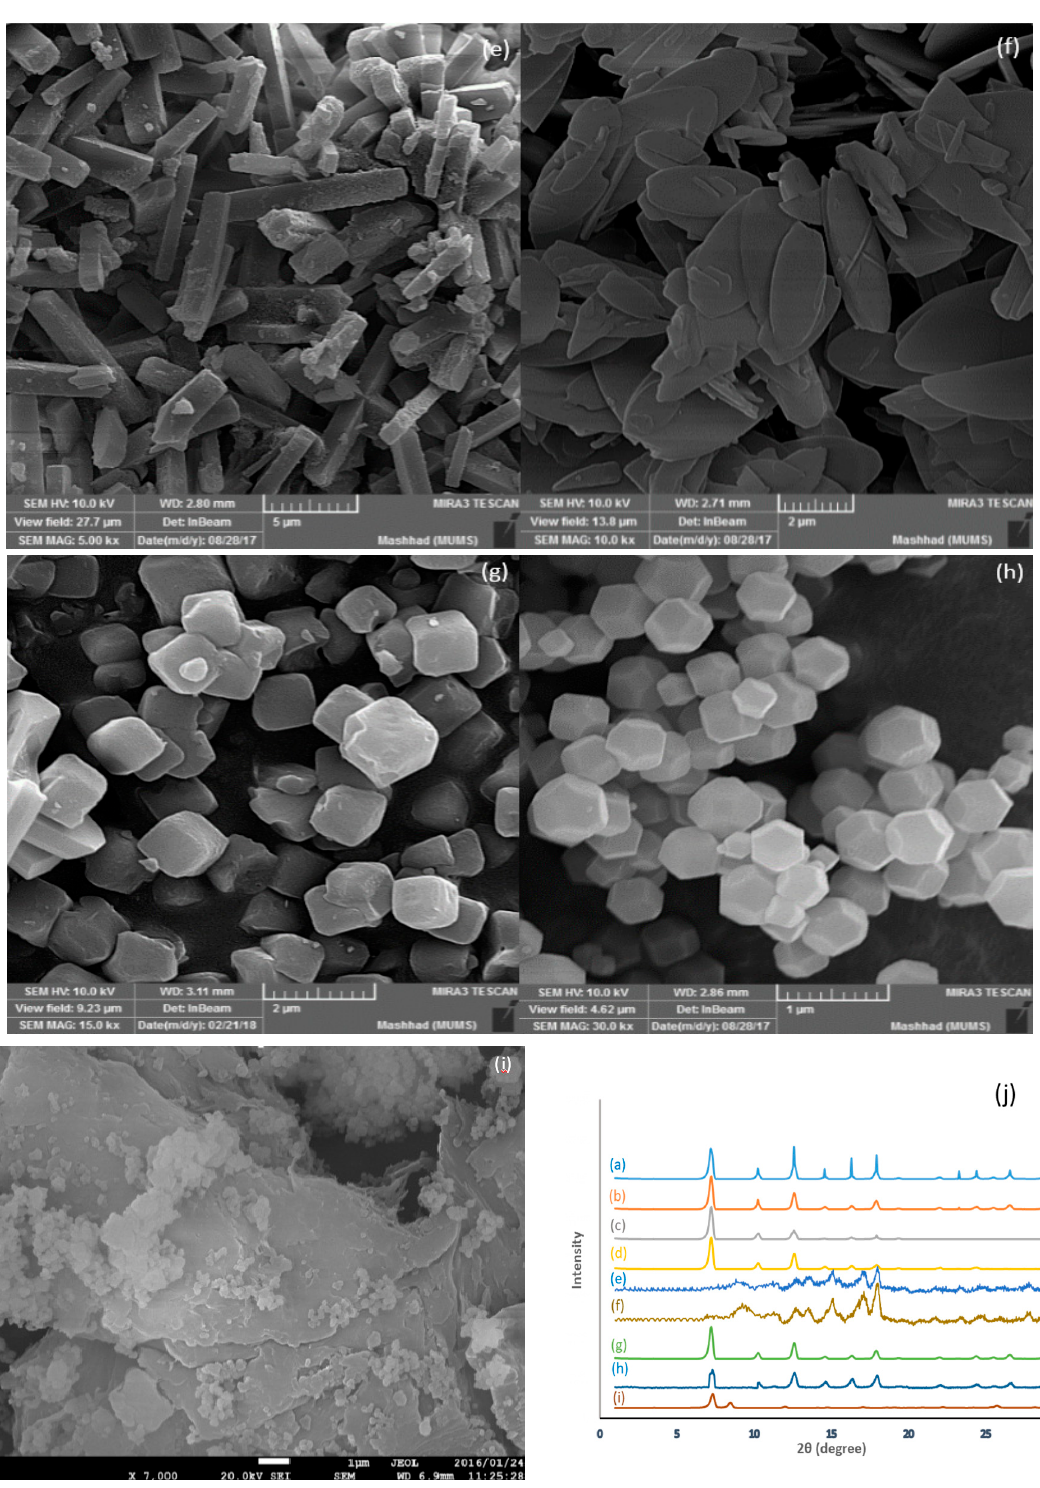
Figure 1. Characteristics of the as-synthesized MOFs: scanning electron microscope (SEM) image of MOFs; ( a ) ZIF-67-OAC, ( b ) ZIF-67-Cl, ( c ) ZIF-67-NO 3 , ( d ) ZIF-67-SO 4 , ( e ) ZIF-8-Cuboid, ( f ) ZIF-8-Leaf, ( g ) ZIF-8-Cube, ( h ) ZIF-8-Octahedron, ( i ) UIO-66, ( j ) x-ray diffraction (XRD) pattern.